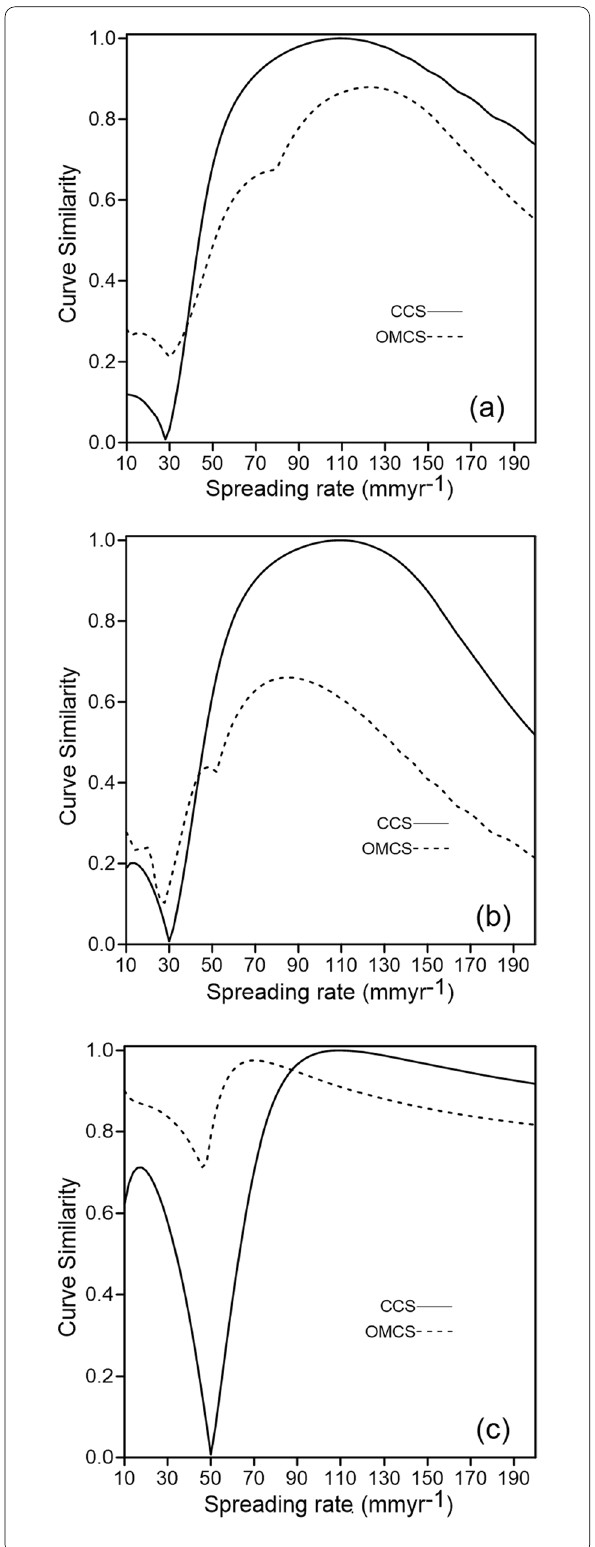
Fig. 10 The identification results of the polarity chron C27, C28 and C29 under different spreading rates. a The identification results of the polarity chron C27; b The identification results of the polarity chron C28; c The identification results of the polarity chron C29. The solid lines represent the curve similarity between the theoretical window and the observed magnetic anomalies at the position of the corresponding steps (CCS). The dashed lines represent the maximum absolute curve similarity values between the theoretical window and the observed magnetic anomalies at the position outside of the corresponding steps (OMCS)